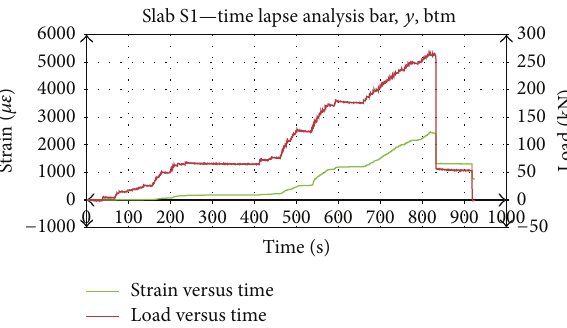
Figure 23: Strain time lapse analysis for gauge 1.4, slab S1.